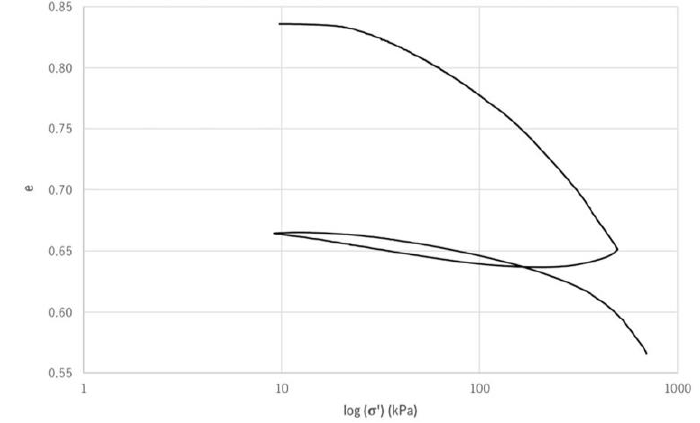
Figure 8. Isotropic consolidation curve of the mine tailing. The critical states theory by Neves (2016) [26] was applied to determine the isotropic consolidation line and the critical states line (CSL). The volumetric compression of the tailings was evaluated until failure using the variation of the void index, expressed in terms of the specific volume (υ). This parameter was calculated based on Equation (1).